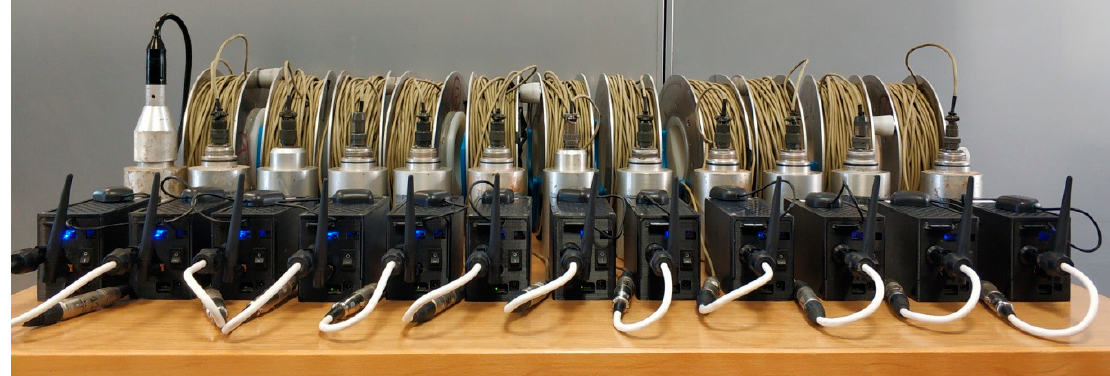
Figure 14. ACN modules connected to Mark L4 1 Hz s ensors.